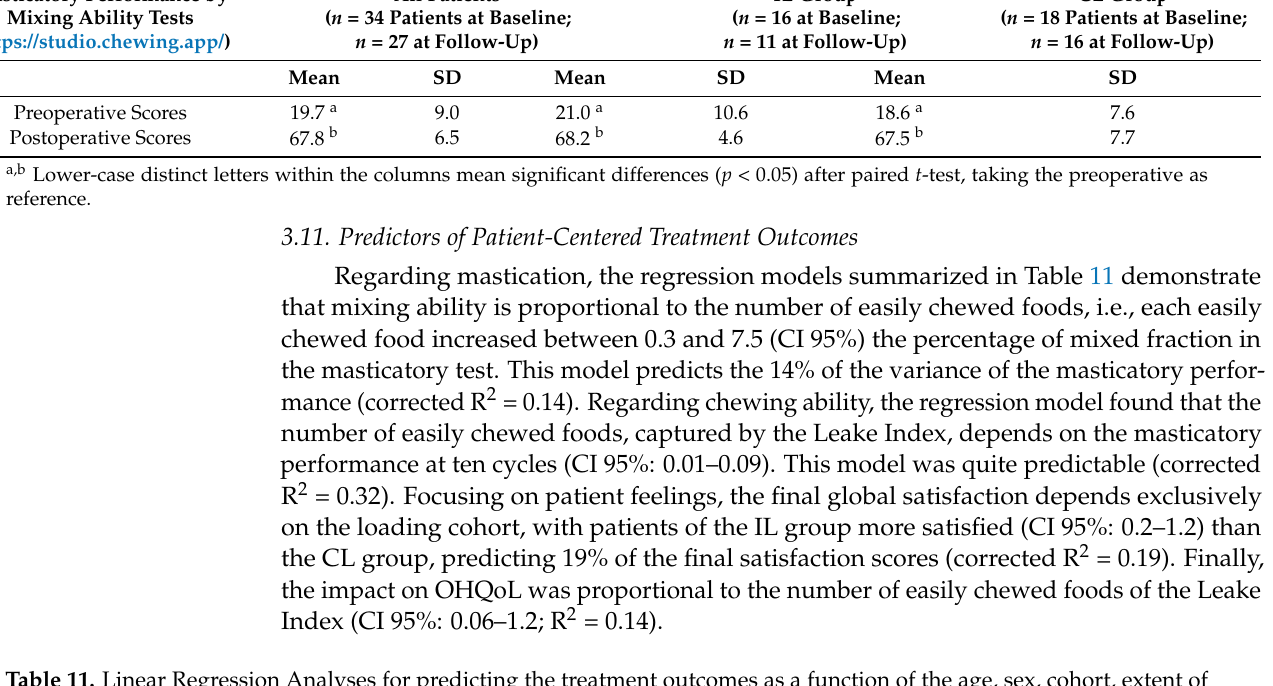
Table 11. Linear Regression Analyses for predicting the treatment outcomes as a function of the age, sex, cohort, extent